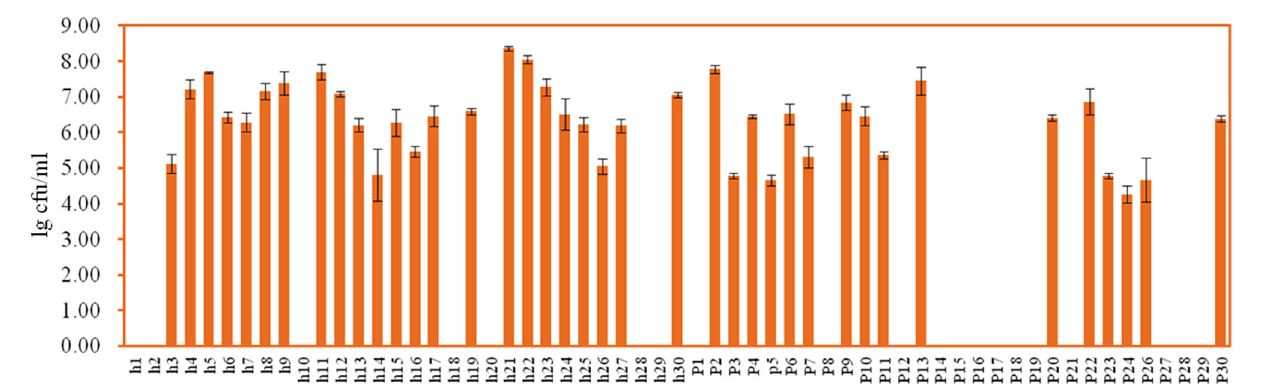
FIGURE 5 | Enumeration of acetic acid bacteria (AAB) in the Suanzhou